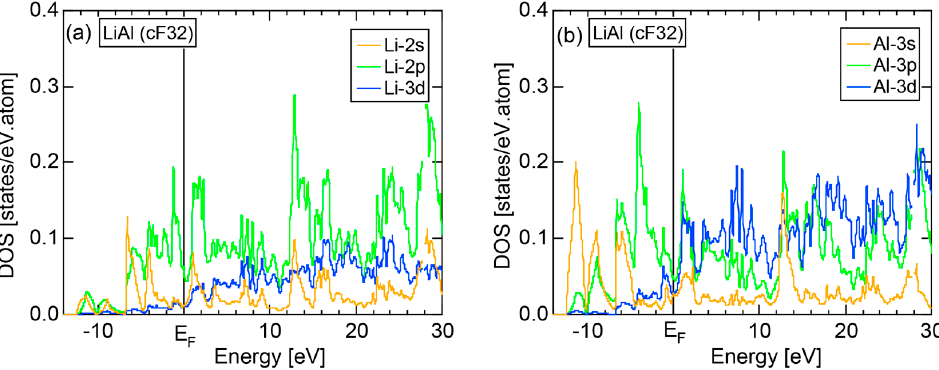
Figure 58. ( a ) Li- and ( b ) Al-pDOSs for LiAl (cF32) [11,41]. Crystals 2017 , 7 , 9